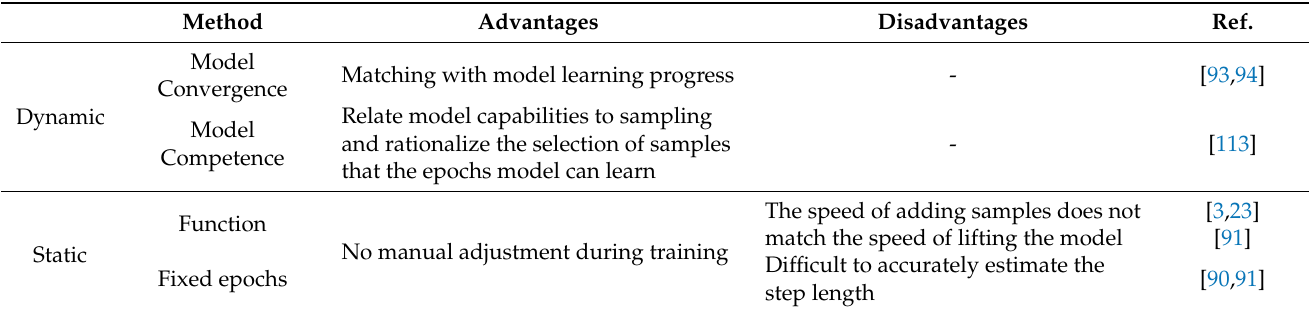
Table 2. Training scheduler with focus on sample adjustment